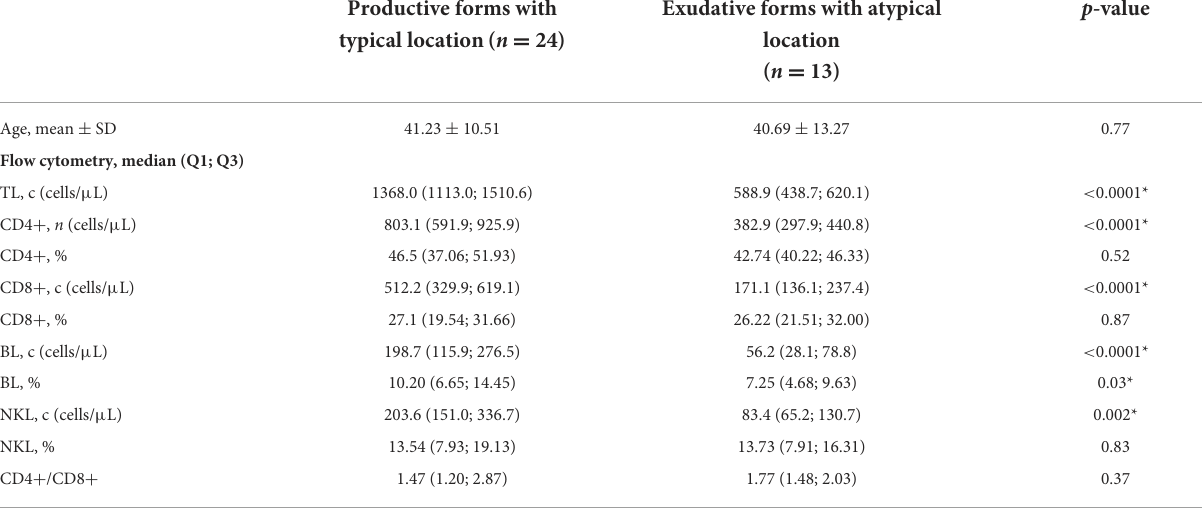
TABLE 3 Demographic characteristics and flow cytometry results in patients with TB according to their chest CT pattern (productive forms with typical location or exudative forms with atypical locations). Productive forms with Exudative forms with atypical typical location ( n = 24) location ( n = 13)